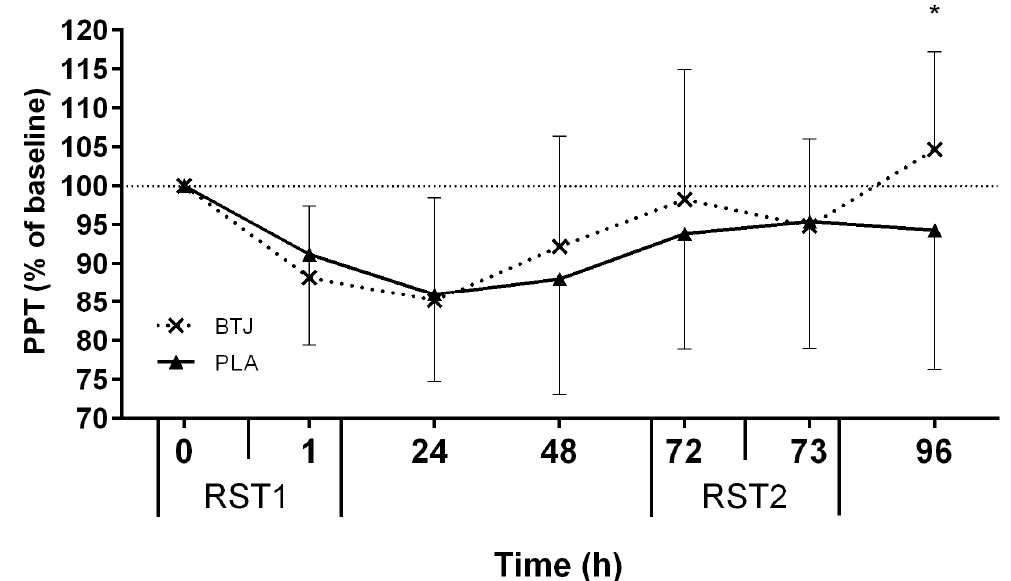
Figure 4. Percentage changes in pressure pain threshold (PPT) between repeated sprint tests (RST1 and RST2). Values presented are average of the three sites measured (calf (CF), rectus femoris (RF) and vastus laterialis (VL). * Indicates interaction effect (beetroot juice (BTJ) vs. placebo (PLA); p < 0.05). Values are mean ± SD ( n = 10 per group).